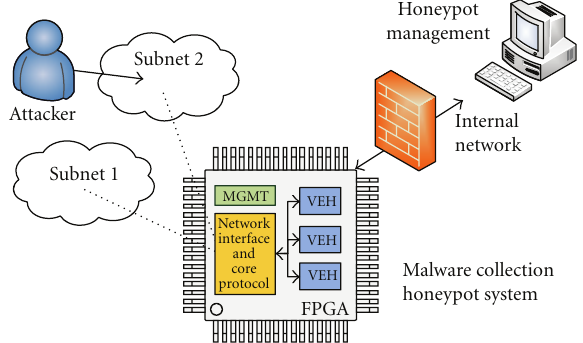
Figure 1: Hardware-based malware